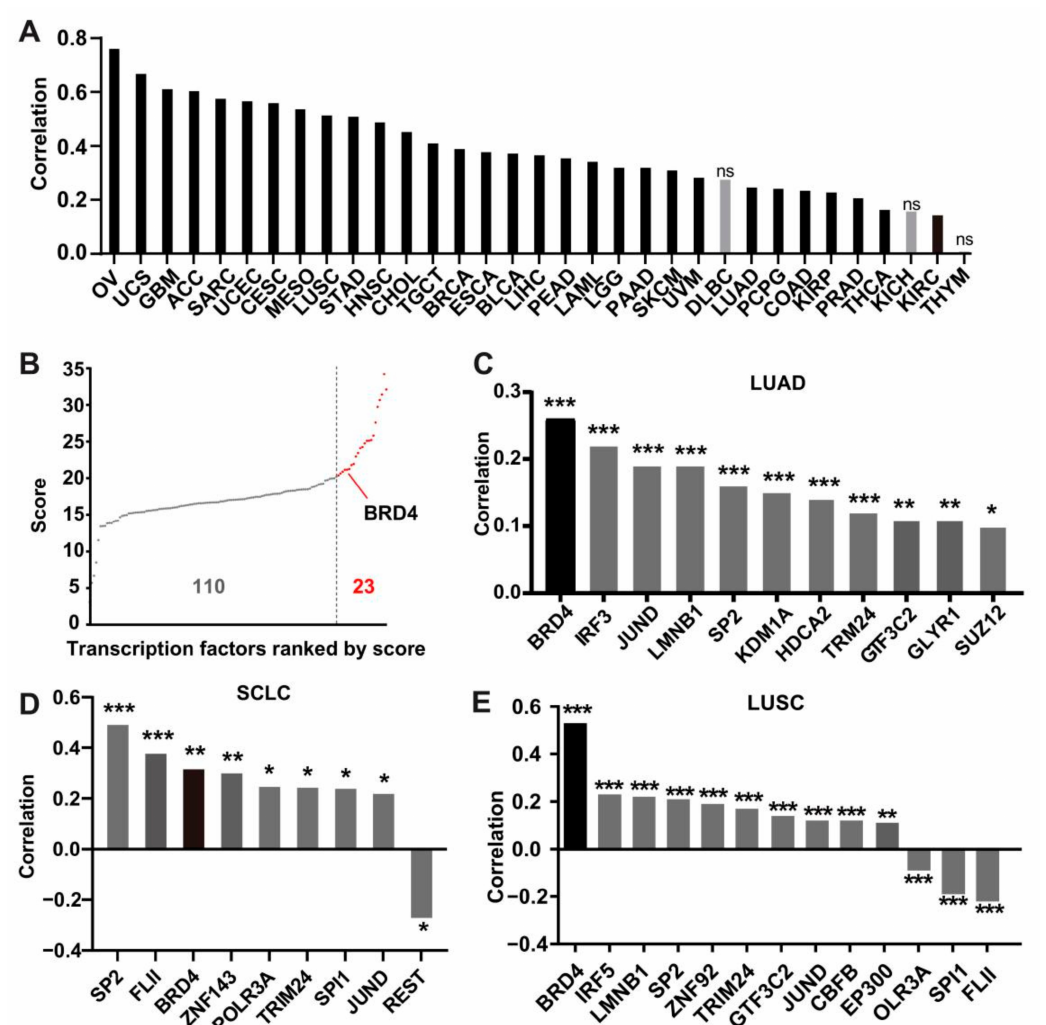
Figure 2. Bioinformatics analysis of factors modulating KEAP1 expression. ( A ) Copy